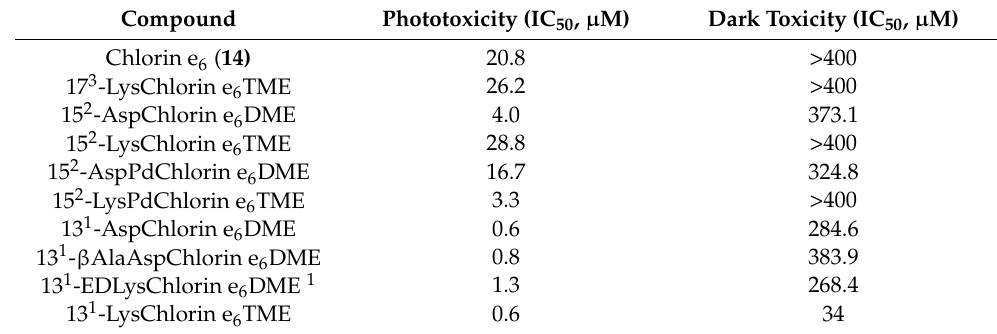
Table 1. Dark- and photo- (1 J/cm 2 ) cytotoxicity of amino acid conjugates of chlorin-e 6 in Hep2 cells. Compound Phototoxicity (IC 50 , µ